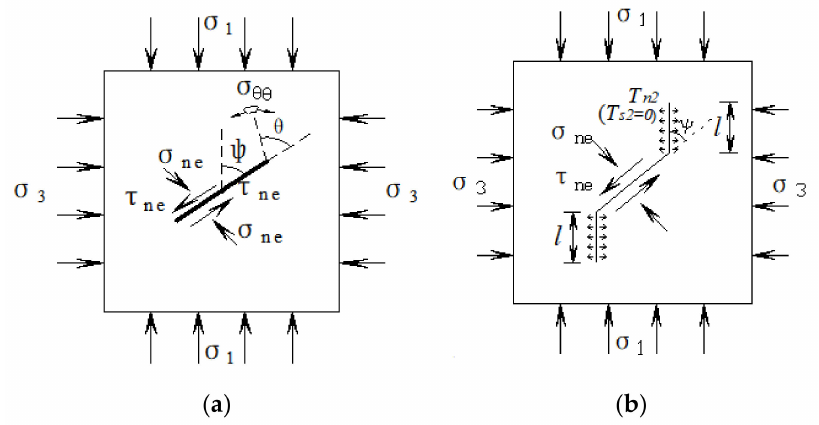
Figure 1. Sketch of wing crack initiation and propagation. ( a ) Wing crack starting crack; ( b ) wing crack